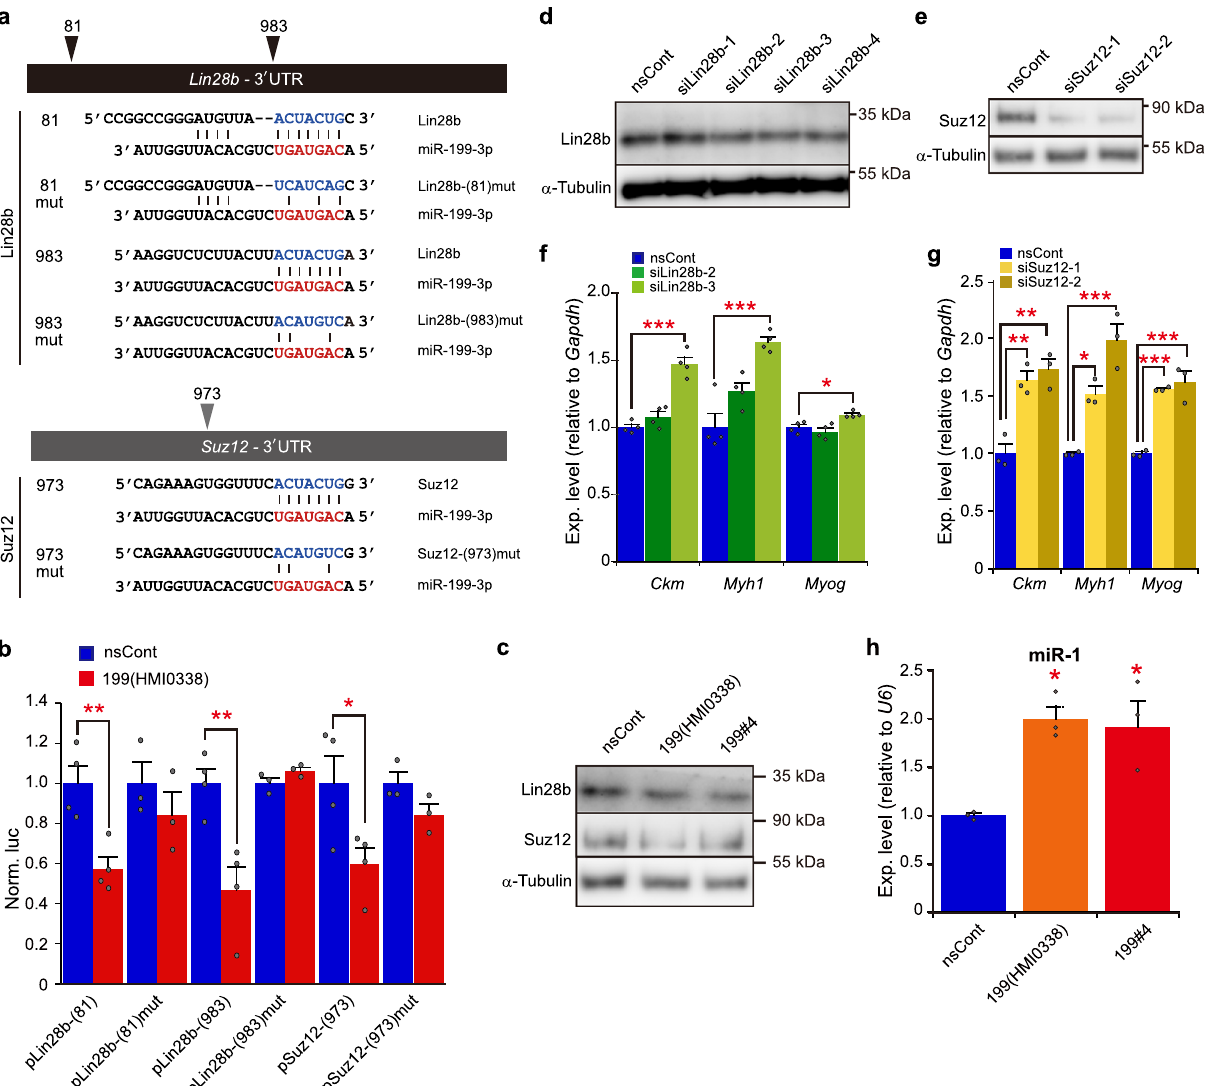
Fig. 3 Target genes for miR-199-3p. a Schematic representation of predicted binding sequences of target genes. Lin28b and Suz12 are candidate target genes for miR-199-3p. The predicted binding sequences and their position are shown. The seed sequence of miR-199-3p is indicated in red. Designed binding sequences with mismatches are also shown. b Suppression of reporter genes carrying the predicted binding sequences by miR-199-3p. Reporter plasmids, pLin28b-(81), pLin28b-(983), and pSuz12-(973), encoding the predicted binding sequences (indicated in a ) in the 3 ′ UTR of the Renilla luciferase reporter gene, and their mutant plasmids, pLin28b-(81)mut, pLin28b-(983)mut, and pSuz12-(973)mut, carrying the mismatched sequences (indicated in a ) were co-transfected with Mission miR-199-3p mimic [199(HMI0338)] or nsCont to C2C12 cells. The Renilla luciferase activity (test reporter) was normalized with the Photinus luciferase (control reporter) activity. The data were further normalized to the data obtained with nsCont as 1. Data are shown as mean ± SEM [ n = at least 3 independent determinations; * p < 0.05, ** p < 0.01 by Student ’ s t test (two-tailed)]. c Suppression of Lin28b and Suz12 by miR-199-3p. C2C12 cells were transfected with miR-199 mimics [199(HMI0338) and our designed miR199#4 (199#4); see Supplementary Fig. 3] and nsCont. Two days later, Lin28b and Suz12 were examined by western blotting. Alpha-tubulin was examined as a loading control. d , e Gene silencing of Lin28b and Suz12 by RNAi. C2C12 cells were transfected with designed siRNAs against Lin28b (four siRNAs) and Suz12 (two siRNAs). Two days later, Lin28b ( d ) and Suz12 ( e ) were examined by western blotting as in c . f , g Expression of myogenic differentiation markers under Lin28b and Suz12 gene silencing. The expression of myogenic differentiation maker genes (indicated) under Lin28b ( f ) and Suz12 ( g ) gene silencing was examined by qRT-PCR and analyzed as in Fig. 2a, b. Data are shown as mean ± SEM (n = at least 3 independent determinations; * p < 0.05, ** p < 0.01, *** p < 0.001 by Dunnett ’ s test). h Production of matured miR-1. C2C12 cells were transfected with miR-199 mimics and nsCont. The level of matured miR-1 in the treated cells was examined by qRT-PCR followed by the delta – delta Ct analysis, using the data of U6 snRNA as an internal reference. The data were normalized with the data of nsCont as 1. Data are shown as mean ± SEM ( n = 3 independent determinations; * p < 0.05 by Dunnett ’ s MiR199#4 delays loss of muscle strength in aged mice . The effect of miR199#4 on muscle function in aged mice is of interest.